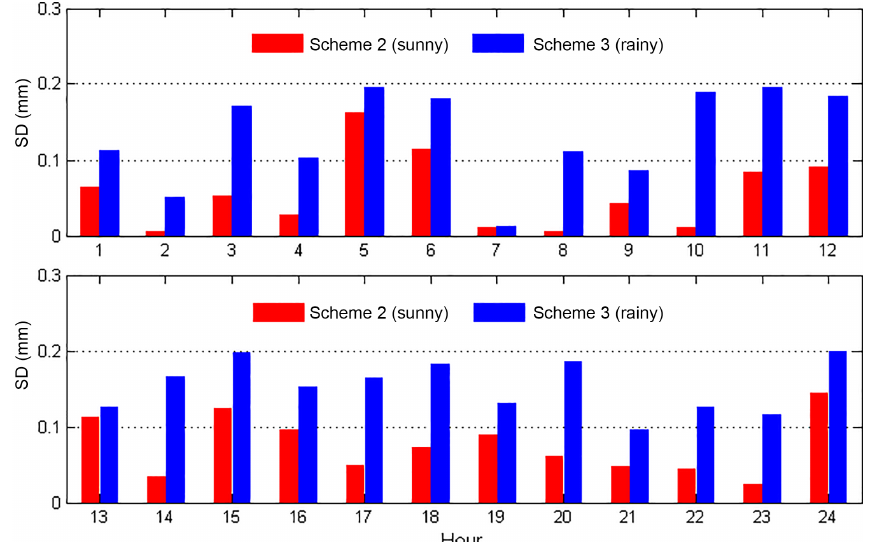
Figure 5. The comparison of SD for Schemes 2 and